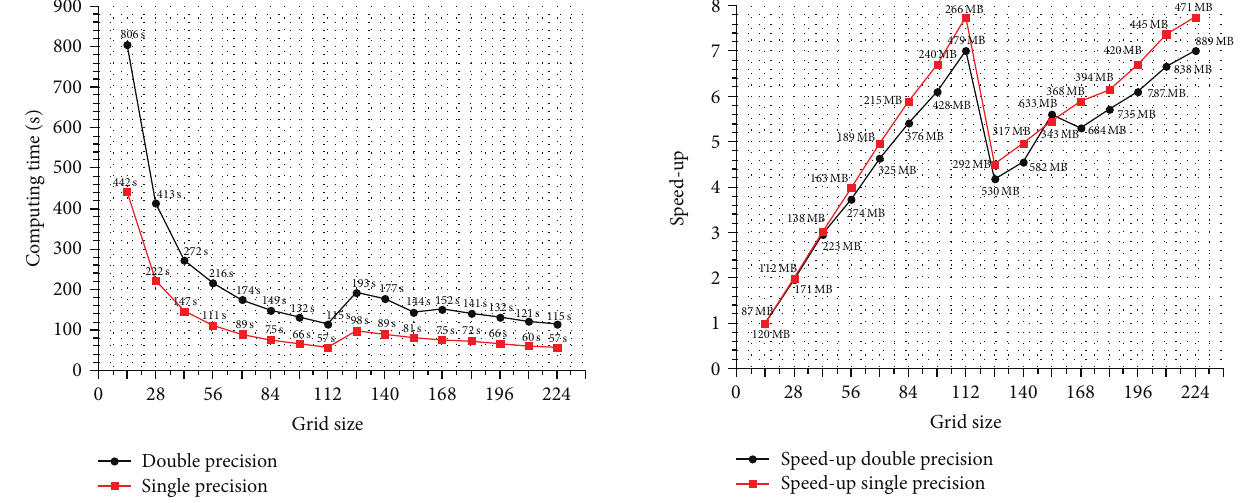
Figure 9: Comparison of the execution time using a variable grid size in multiples of 14, in double and single precision.